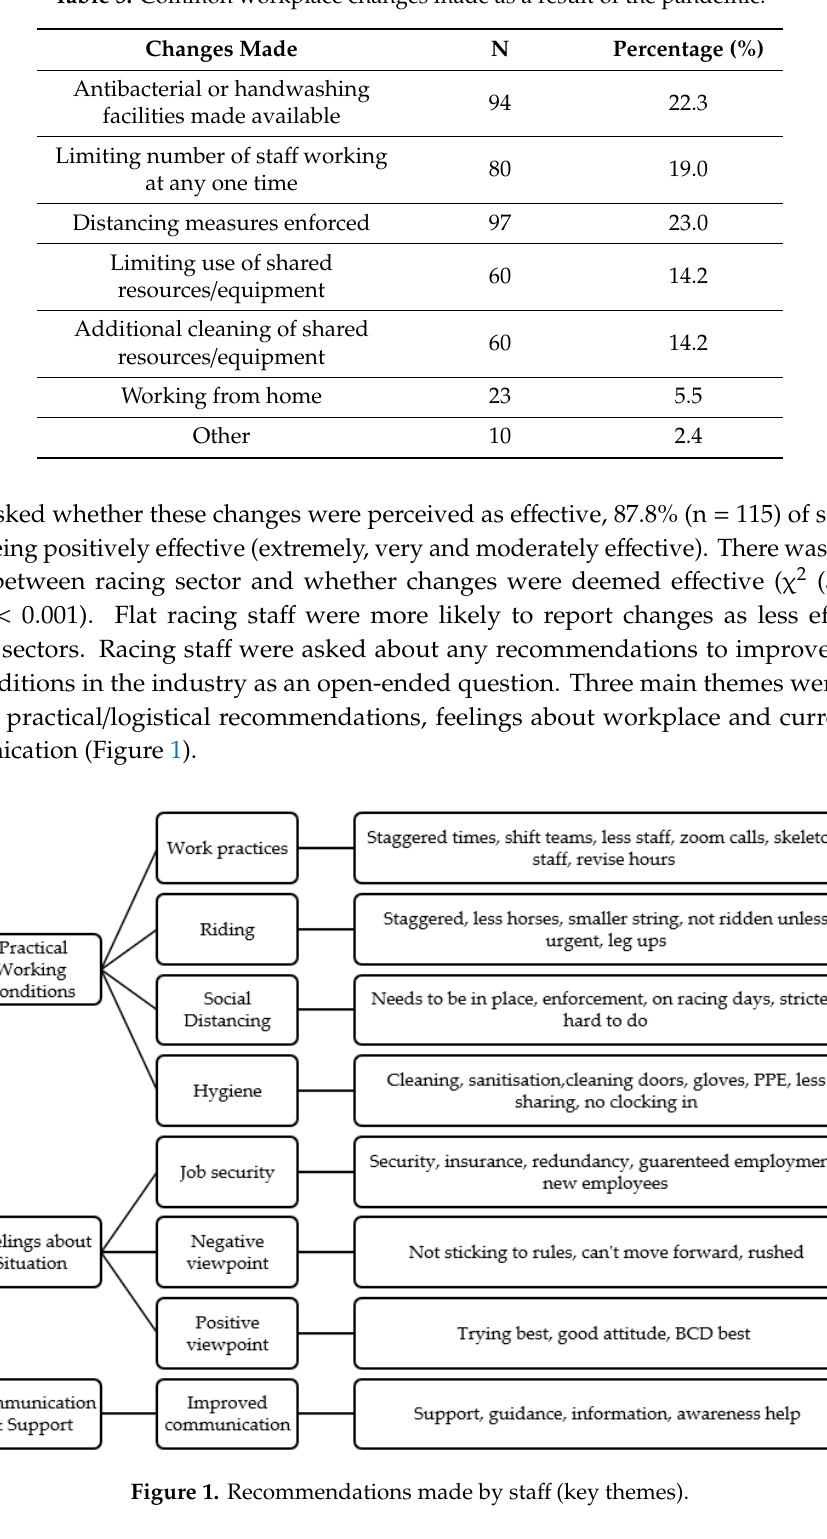
Table 5. Common workplace changes made as a result of the pandemic.